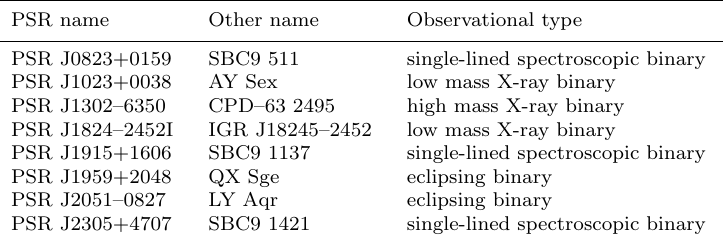
Table 3. Radio pulsars in binaries of other observational